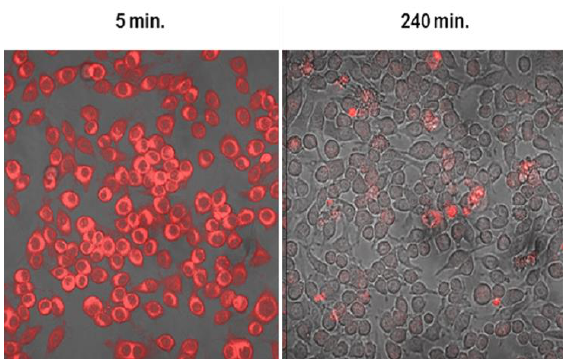
Figure 8. Drug release from DOX loaded Ma over time. Ma were incubated with 100 µg/mL DOX for 2 min, followed by double wash to remove non-incorporated drug. Images were captured with fluorescence microscopy 5 min 240 min later. DOX is shown by red reflectance dispersed throughout the cells.